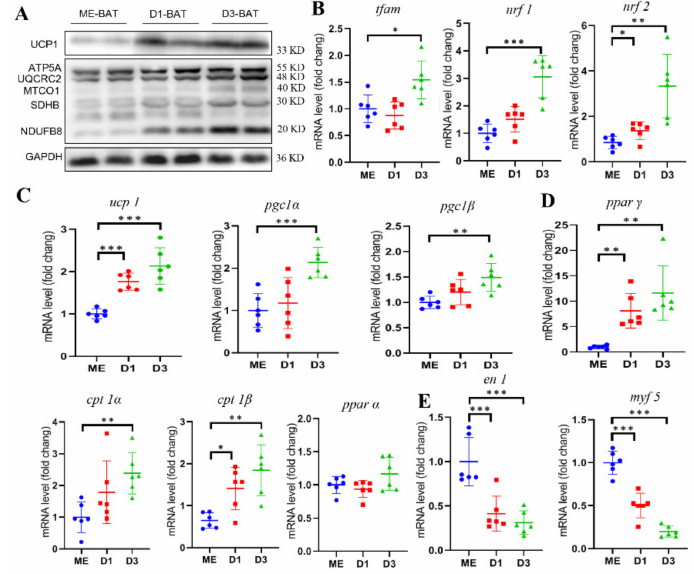
Figure 3. neBAT is more active than embryonic BAT in mice. ( A ) The protein expression levels of ucp1 and oxphos (including atp5a , uqcrc2 , mtco1 , sdhb , and ndufb8 . The molecular weight of each band is marked on the right) in neBAT (D1 and D3) and ME-BAT. ( B ) The mRNA expression levels of mitochondrial genes (including tfam , nrf1 , and nrf2 ), ( C ) thermogenic genes (including ucp1 , pgc1 α , pgc1 β , cpt1 α , cpt1 β , and ppar α ), ( D ) brown adipogenic synthesis ppar γ , and ( E ) brown adipocyte progenitors (including myf5 and en1 ). Data are presented as the mean ± sem n = 6 per group. The significance of the di ff erence was set at * p < 0.05, ** p < 0.01, and *** p < 0.001 when compared to ME-BAT,